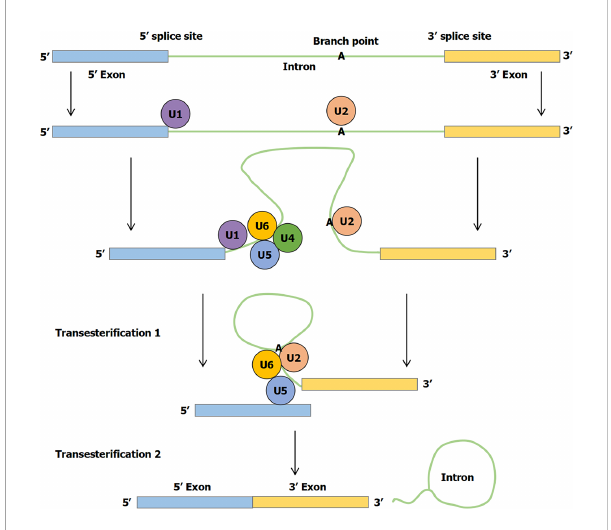
FIGURE 1 The mechanism of RNA splicing. First, a branch point A nucleotide located near the 3 ′ splice site of the intron sequence attacks the 5 ′ splice site and clefts it. The 5 ′ end of the intronic sequence cleavage is thus covalently linked to this A nucleotide, forming the branched nucleotide. Second, the 3 ′ -OH end of the fi rst exon sequence created in the fi rst step is added to the beginning of the second exon sequence to cleave the RNA molecule at the 3 ′ splice site. Thus, the two exonic sequences are linked to each other and the intronic sequence is released as a